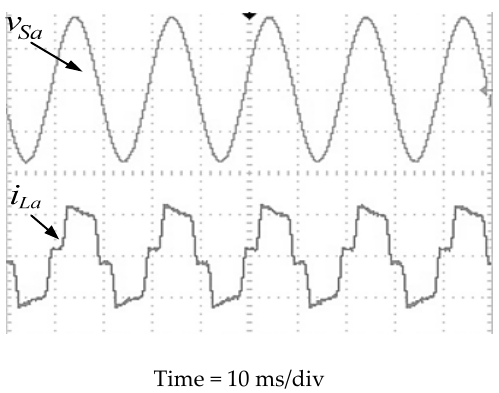
Figure 15. Experimental result displaying the phase a source voltage v Sa (40 V/div) and source current i Sa (5 A/div) waveforms before compensation.